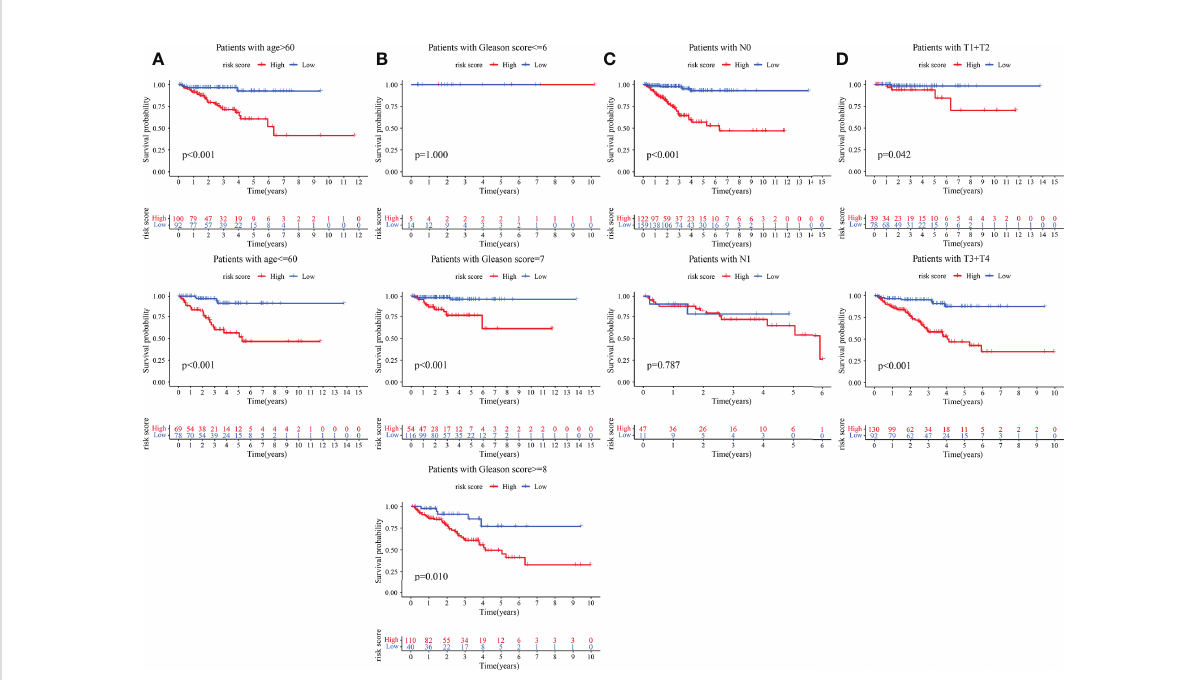
FIGURE 7 KM curves based on clinical features for BFFS of this signature in TCGA. The KM curves of patients based on ages (A) ; Gleason scores (B) ; pathological stage (C) and pathological stage (D)